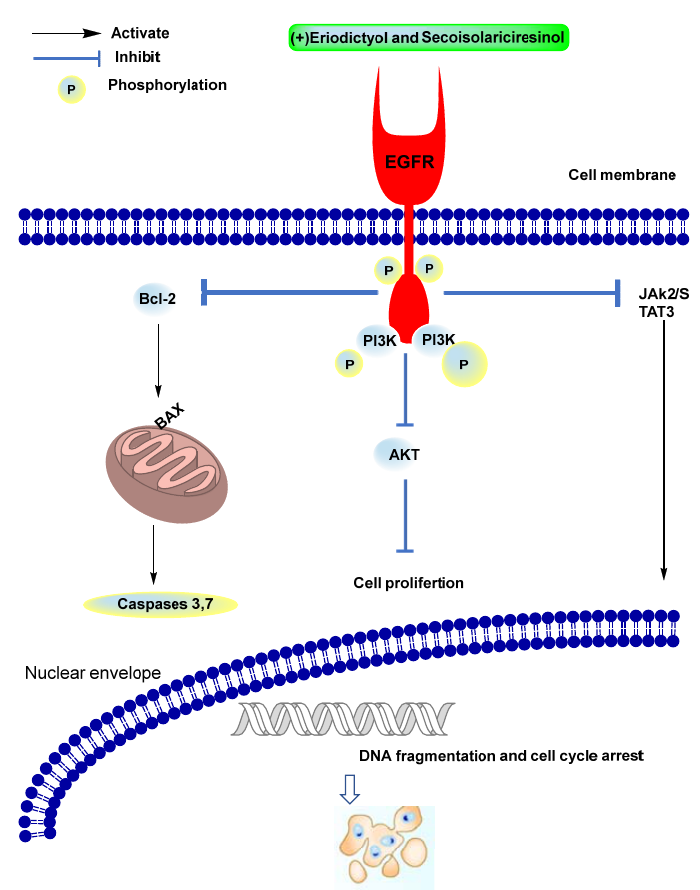
Figure 3. Schematic diagram of the EGFR-based pathway of anticancer activity .